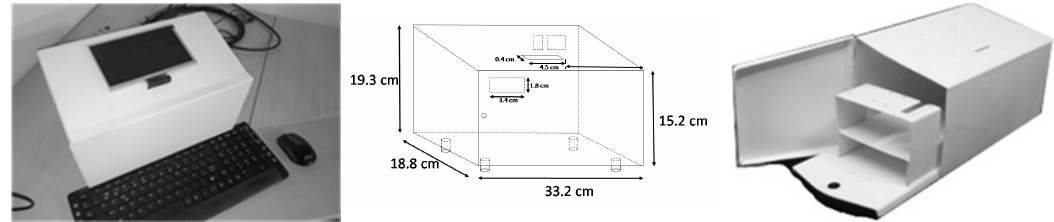
Figure 8. Piezo-diagnoster hardware